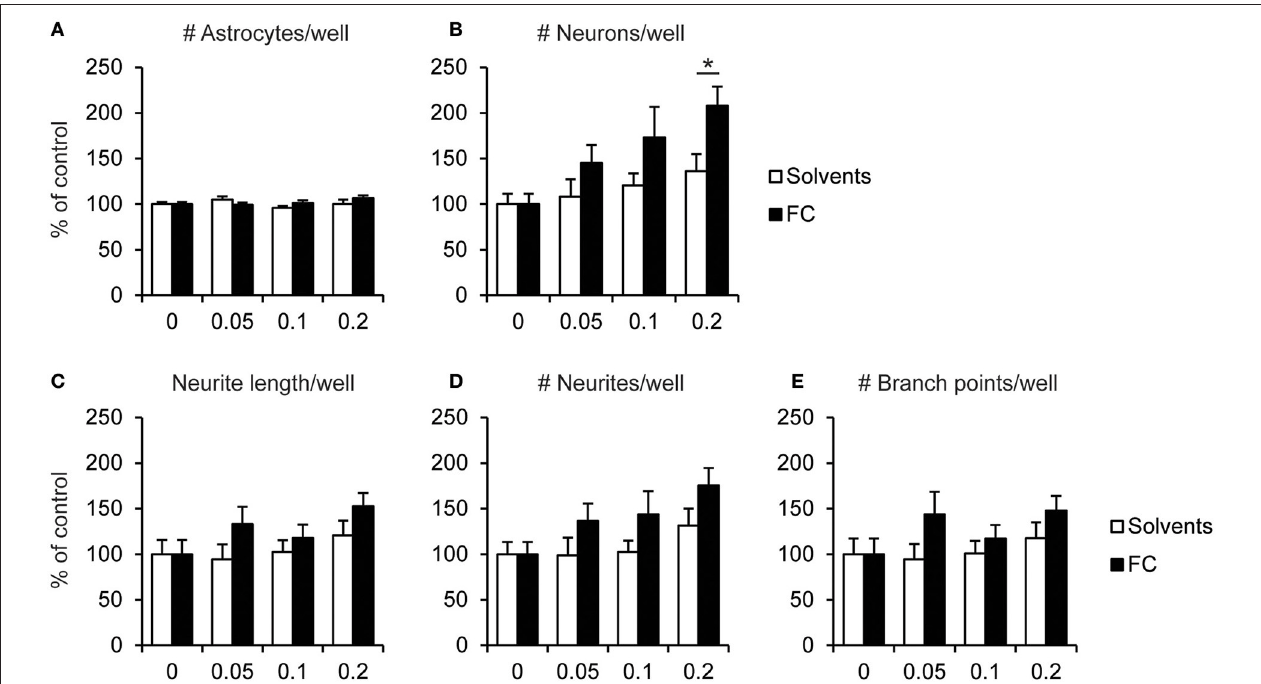
FIGURE 3 | Effects of FC on cell survival and neurite morphology in primary neuron-astrocyte co-cultures. Analysis of (A) number of astrocytes, (B) number of neurons, (C) total neurite length, (D) number of neurites, (E) number of branch points measured per well for: no supplementation (0) or supplementation of 0.05x,